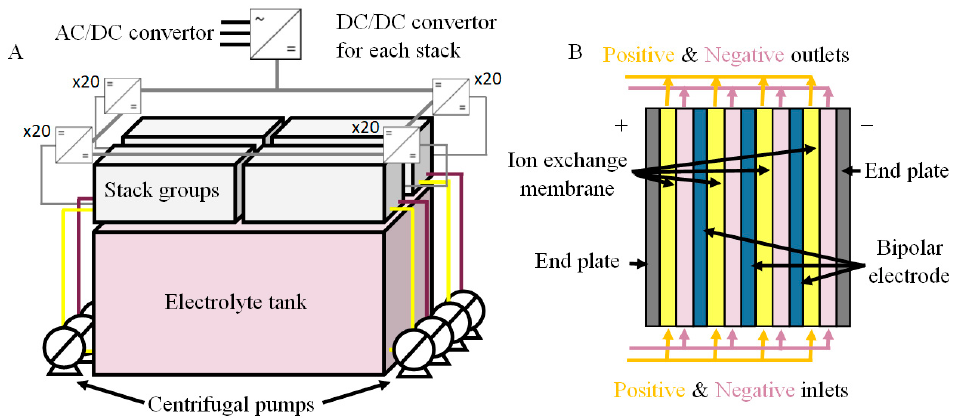
Figure 1. ( A ) Simple representation of the 200 kW/400 kWh vanadium redox flow battery (RFB) showing the four stacks and electrolyte tanks; ( B ) Schematic of the bipolar plates used in the RFB stacks.